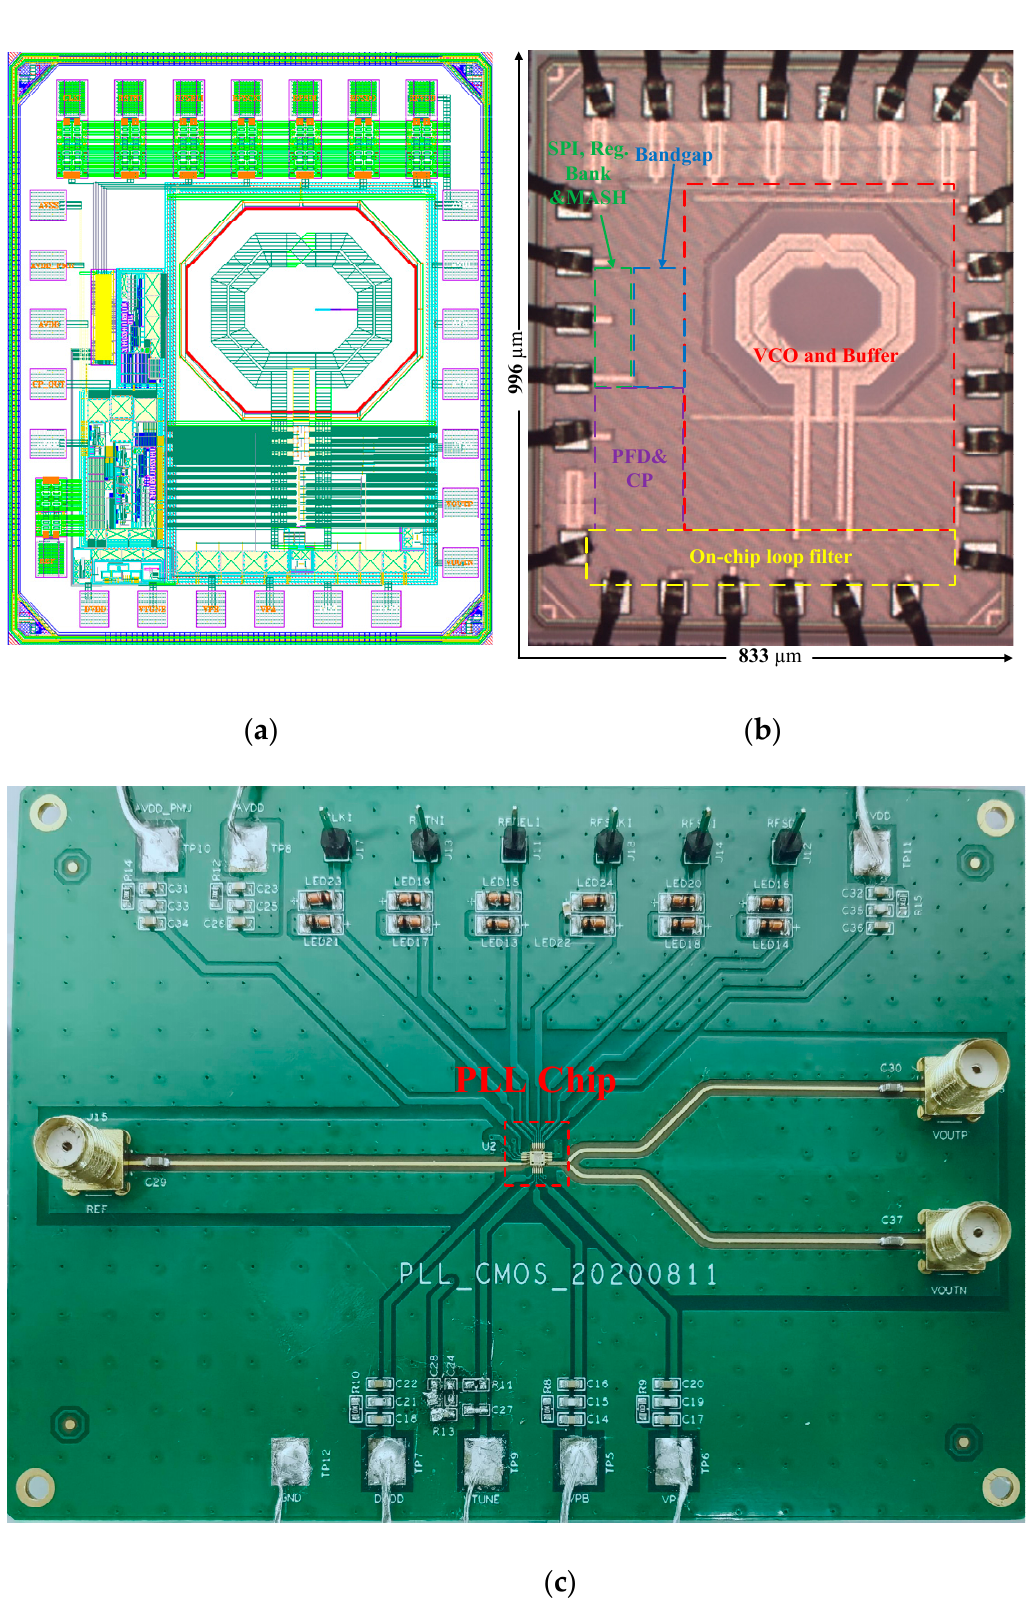
Figure 10. PLL chip: ( a ) layout photograph; ( b ) chip micro-photograph; ( c ) PCB substrate.